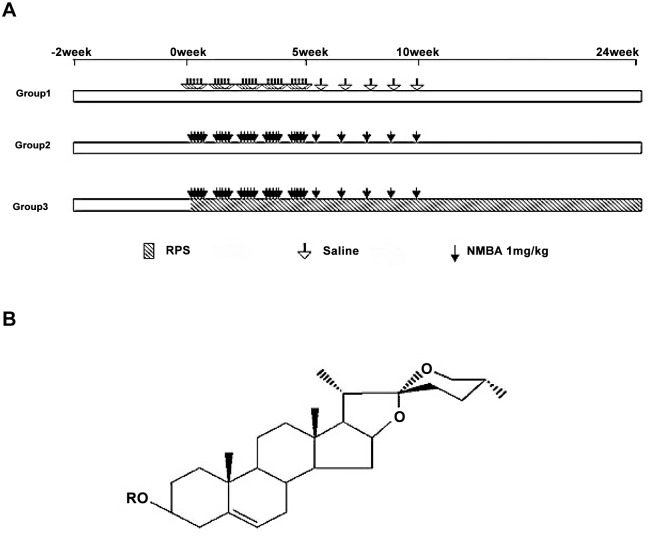
The schematic diagram of the experimental design for NMBA injection and RPS administration.
A. A schematic representation of experimental protocol. The empty arrows indicate subcutaneous injection of saline. The solid arrows indicate subcutaneous injection of NMBA. The shaded area represents oral RPS administration. B. The chemical formula of RPS. The letter “R” indicates that different functional groups can be at that position, resulting in different types of RPS with various molecular structures.